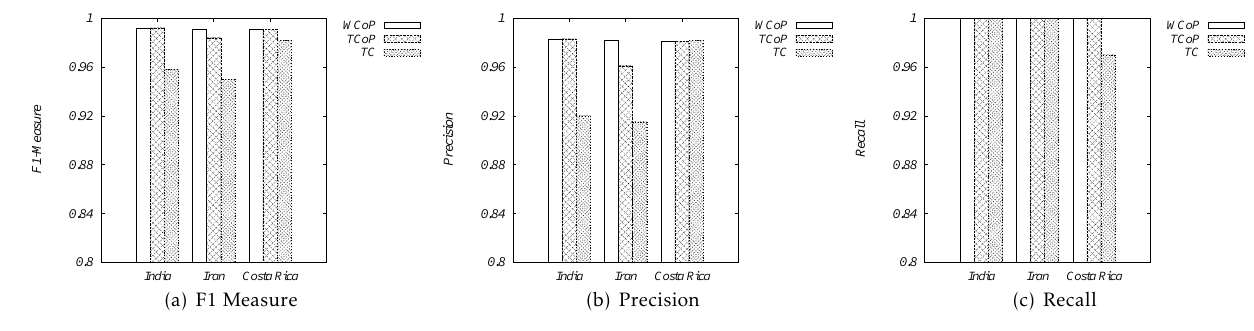
Figure 8. F1, Precision and Recall of WCoP, TCoP and Text Classification on sample pages of “places" domain